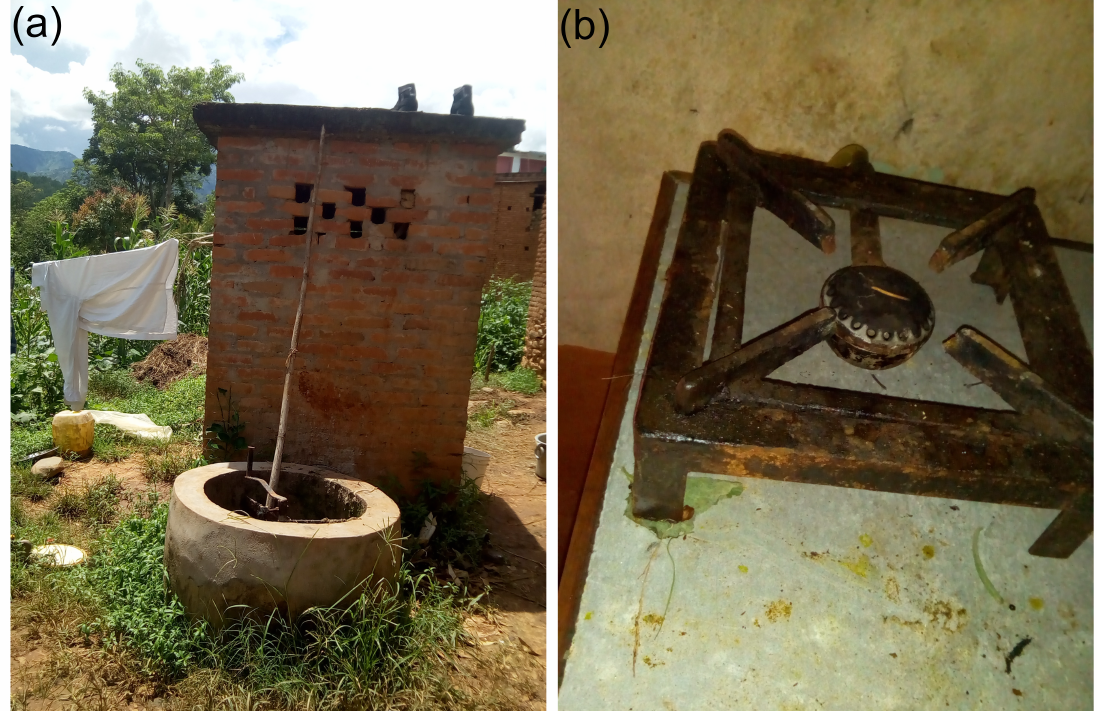
Figure 1. Biogas system components. ( a ) The cement ring is the mixing chamber (with a hand-crank steel mixer) for adding fuel to the digester. The latrine, behind the mixing chamber feeds directly into the digester. ( b ) A typical biogas stove